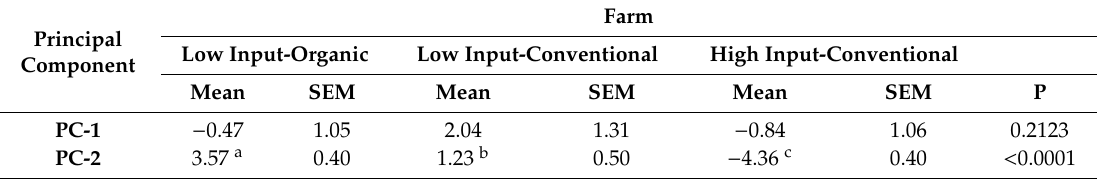
Table 3. ANOVA of the Principal Components (PCs) eigenvalues. Data are reported as mean ± SEM.